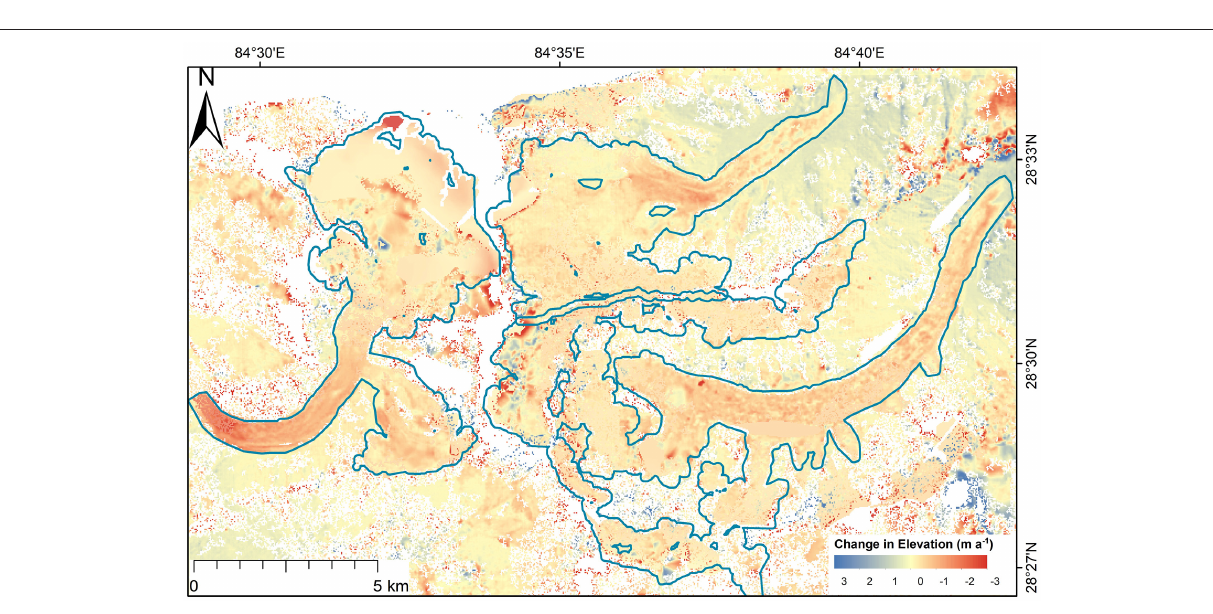
FIGURE 6 | Mean annual change in surface elevation between 1970 and 2013 for Thulagi, Punggeon and Hinang Glaciers. The glacier outlines (shown in blue) are from